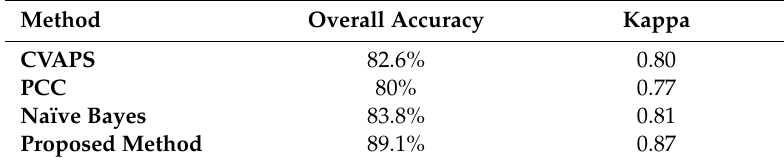
Table 4. Accuracy assessment of LULC type-of-change identification in Experiment